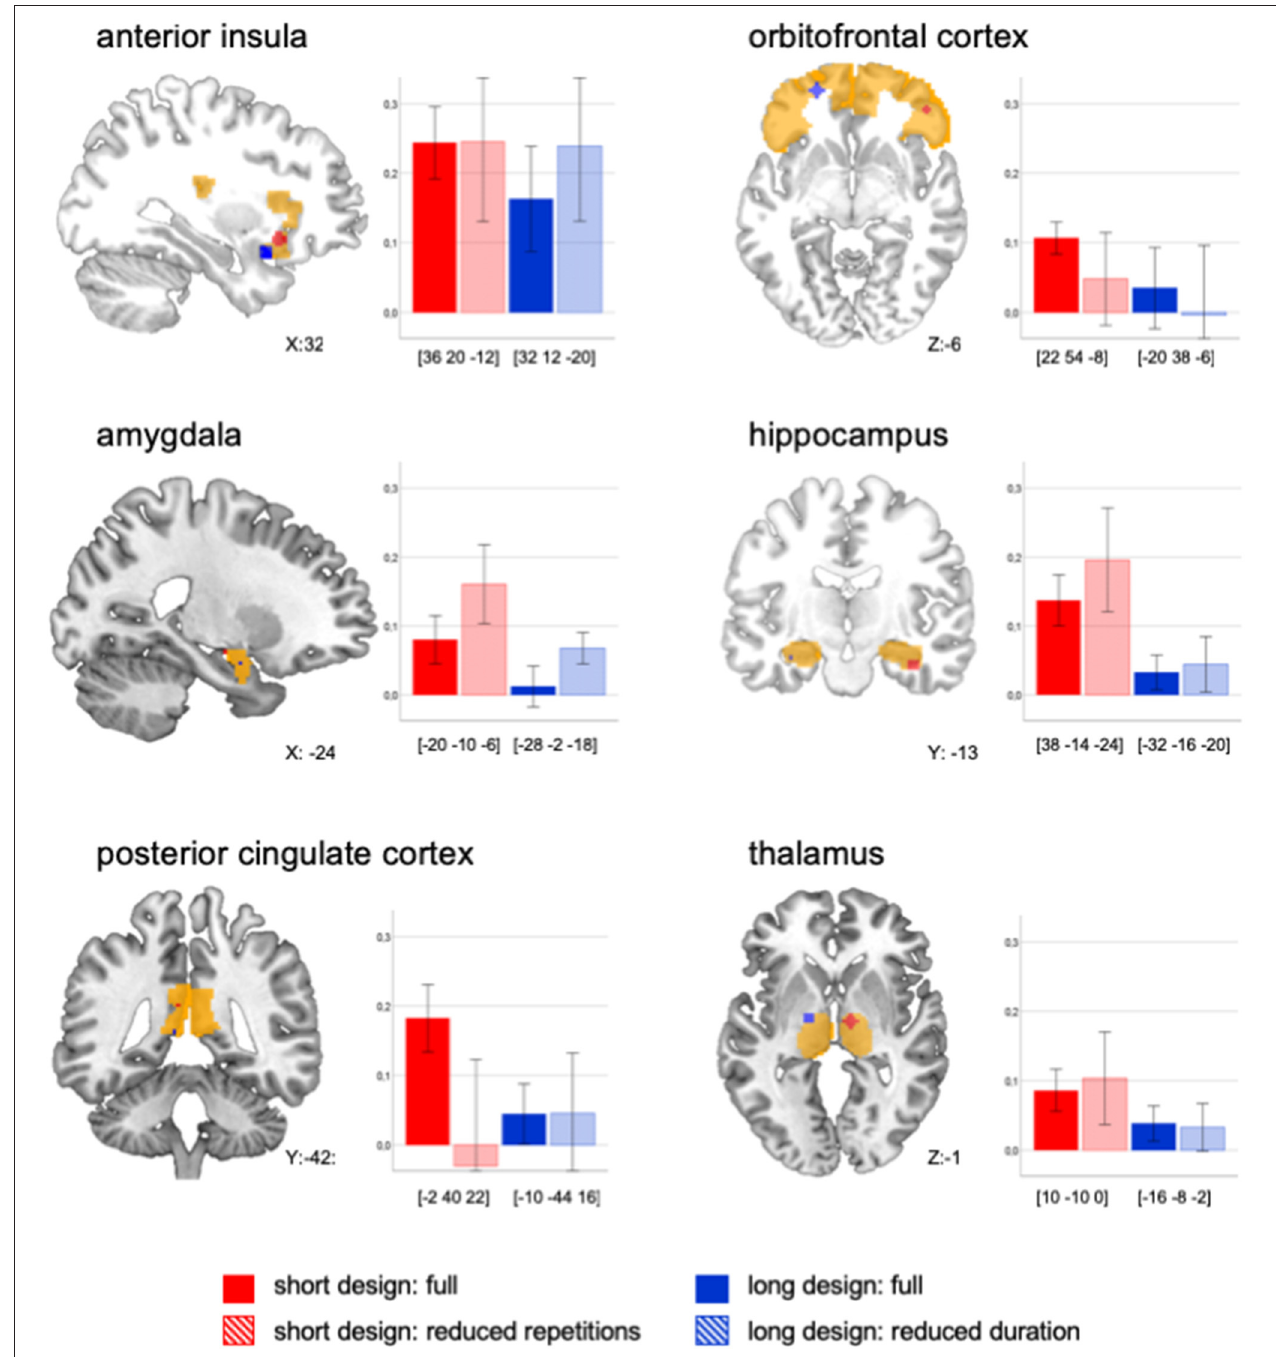
FIGURE 1 | Peak activations displayed for each ROI and each design. Beta mean values (baby body odor vs. baseline) extracted for a 4mm sphere around the peak value (RH, right hemisphere; LH, left hemisphere, and MNI coordinates are displayed in square brackets) of each ROI and for each design across all subjects ( n = 10). Please note in the anatomical visualization, that peak activations may have occurred on different hemispheres. Error bars display 95% CI.